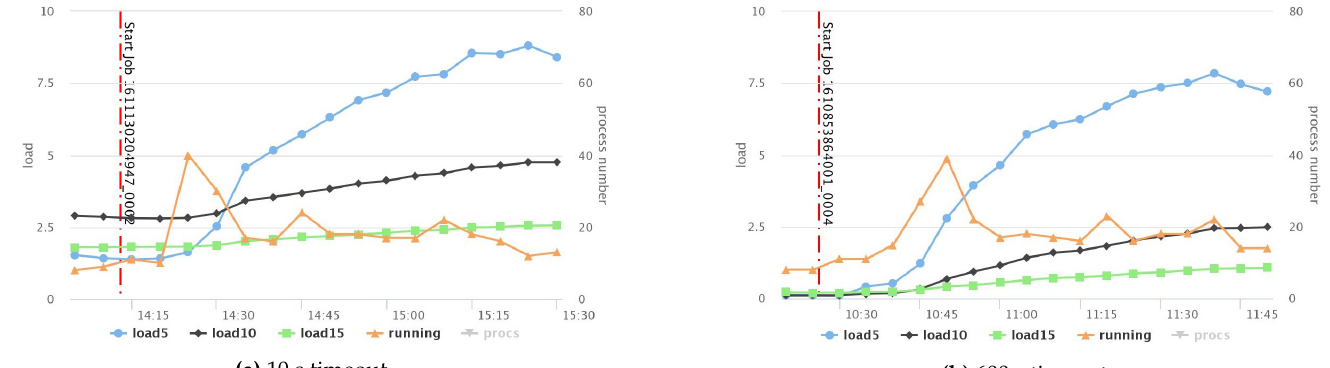
Figure 13. Comparison between system loads when using small and default timeouts.